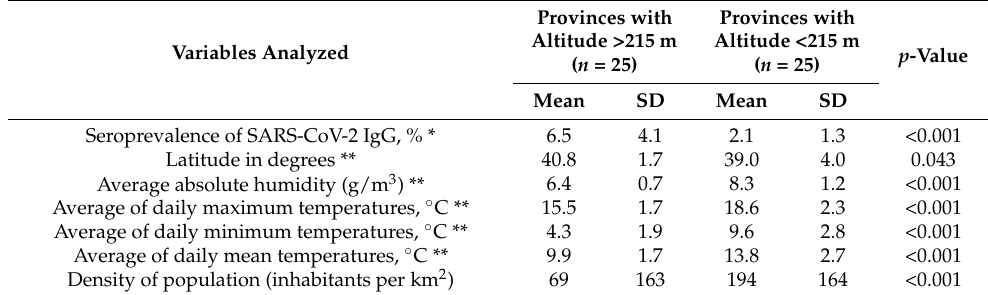
Table 3. Comparison of average characteristics between provinces ( n = 50) with altitude above and below the median (215 m). Spain,